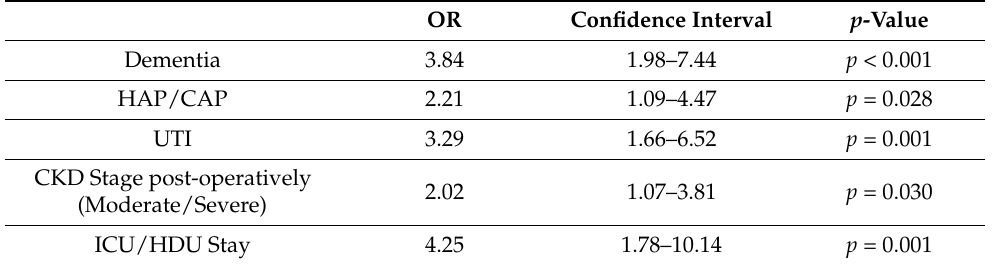
Table 4. Coefficients and odds ratio estimates outlining the risks/associations of post-operative delirium.